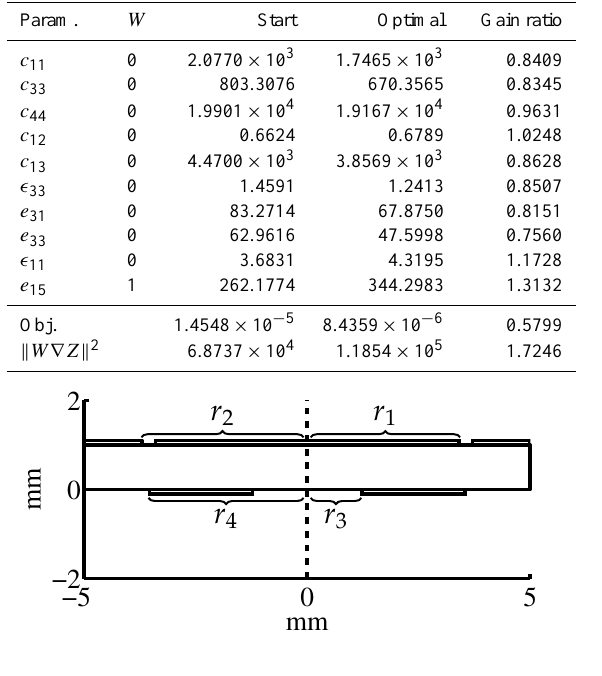
Table 2. Binary weights: Improvement of sensitivity of impedance w.r.t. material parameters using W = Table 1. Uniform weights: Improvement of sensitivity of impedance w.r.t material parameters using W = diag (0 , 0 , 0 , 0 , 0 , 0 , 0 , 0 , 0 , 1) : The sensitivity w.r.t e 15 has increased. However, the sensitivity toward other diag (1 ,..., 1) : The sensitivity has increased for all the parameters with exception of e 15 . These are the best parameters has mainly decreased. Objective function values are shown unscaled. Figure shows resulting component-wise results we have computed so far. Objective function values are shown unscaled. Figure shows